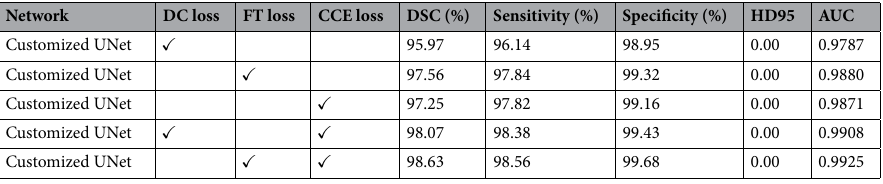
Table 2. Segmentation results of the customized UNet.